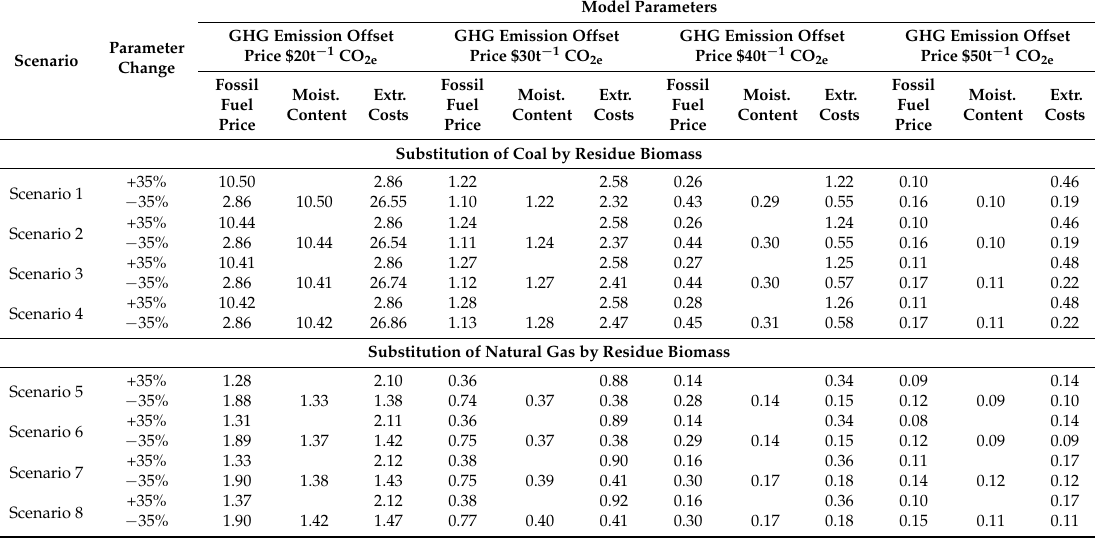
Table 3. Elasticity of emissions offsets (percent change in offsets due to a change in fossil fuel price, moisture content, or residue extraction costs) by scenario * and offset price